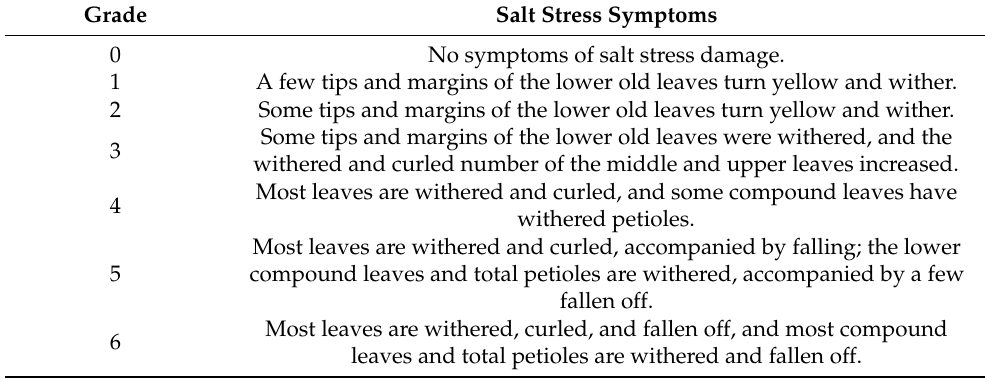
Table 1. Symptoms levels of salt injury